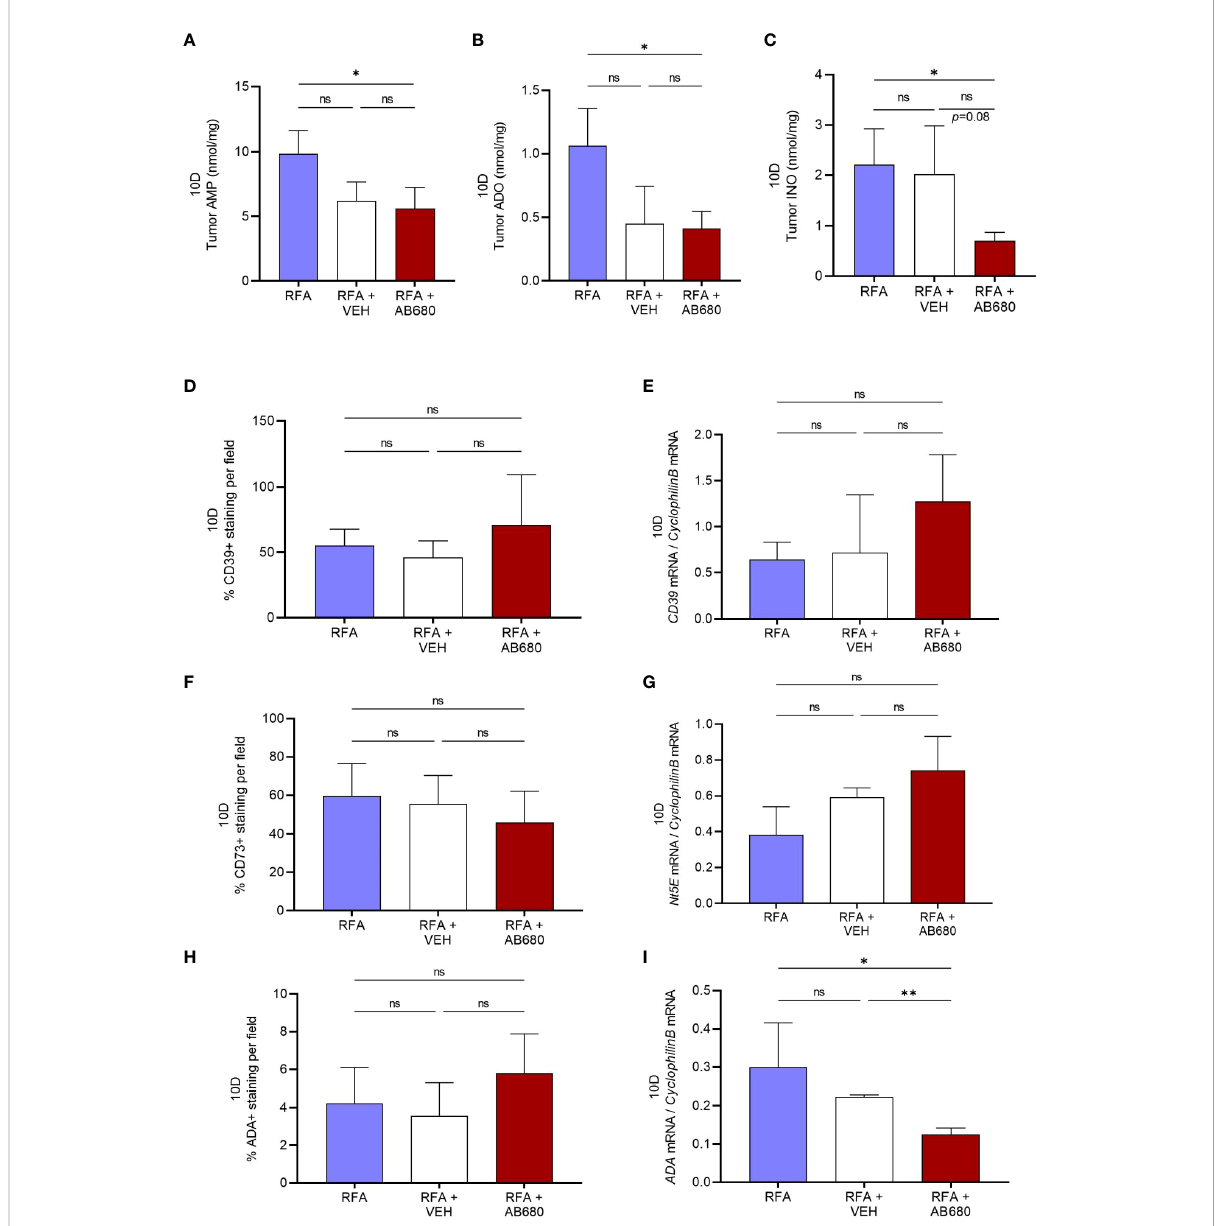
FIGURE 4 CD73 inhibition in vivo in combination with RFA impairs ADO pathway. (A – C) , Tumor AMP, ADO and INO content were signi fi cantly reduced in combination treatment (RFA+AB680) when compared to RFA alone ( p < 0.05) 10 days after treatment. IHC and qPCR analysis showed no signi fi cant differences the expression levels of CD39 (D, E) or CD73 (F – G) . Similarly, no differences were found in ADA protein expression by IHC (H) . However, Ada mRNA levels were found decreased (I) only in combination treatment (RFA+AB680) when compared to both RFA ( p < 0.05) and RFA+VEH ( p < 0.01). One-way ANOVA was used for group comparisons. *p<0.05 **p<0.01 ns (not signi fi